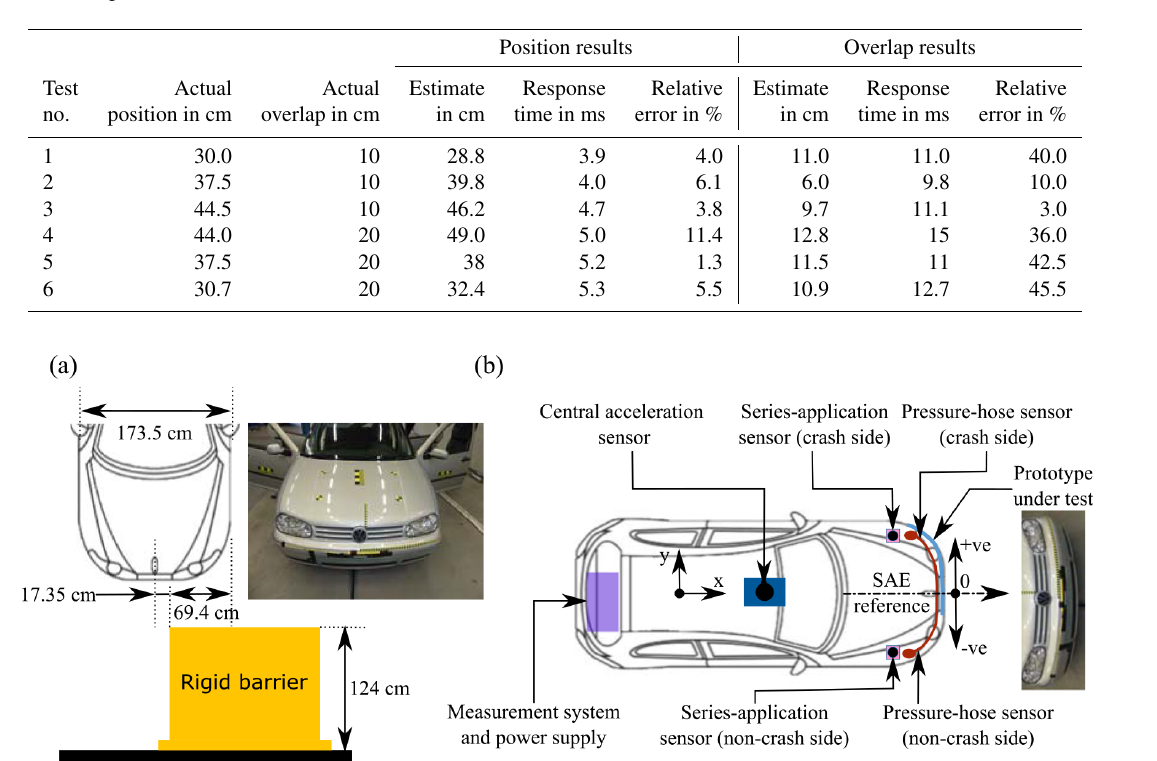
Figure 8. Crash test: (a) test setup and (b) sensor positions and measurement system (SAE reference for position values is the center of the vehicle